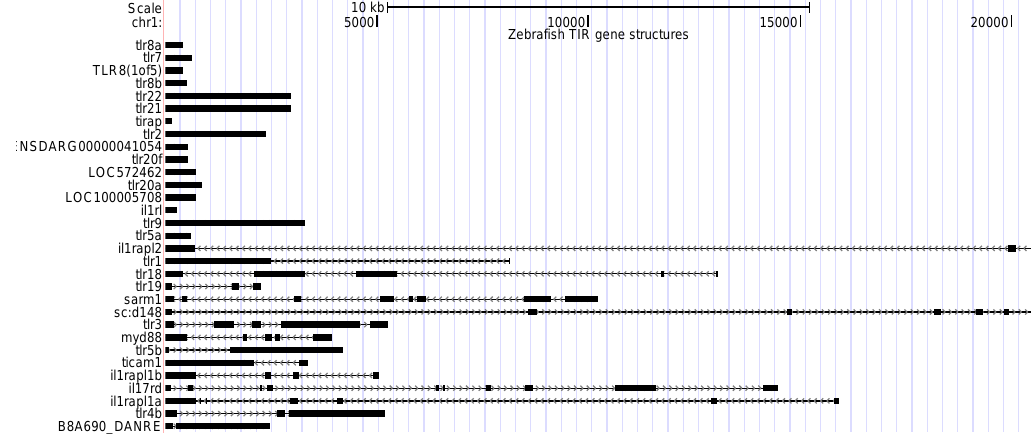
Figure 4: Gene structures of 31 zebrafish TIR domain-containing